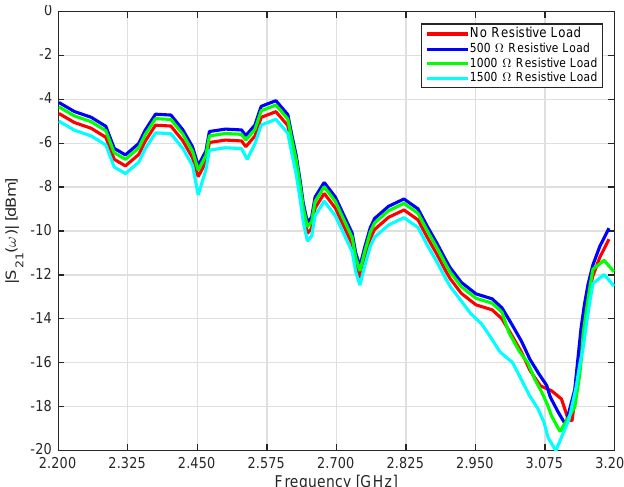
Figure 9. A photo of the tag prototype demonstrator with five resonators and two broadband circularly polarized antennas.